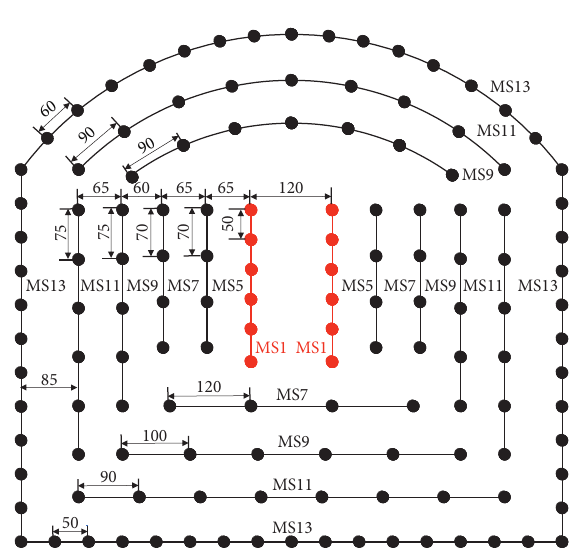
Figure 3: Blasthole arrangement and detonation sequence for blasting excavation of the traffic tunnel (units: cm).